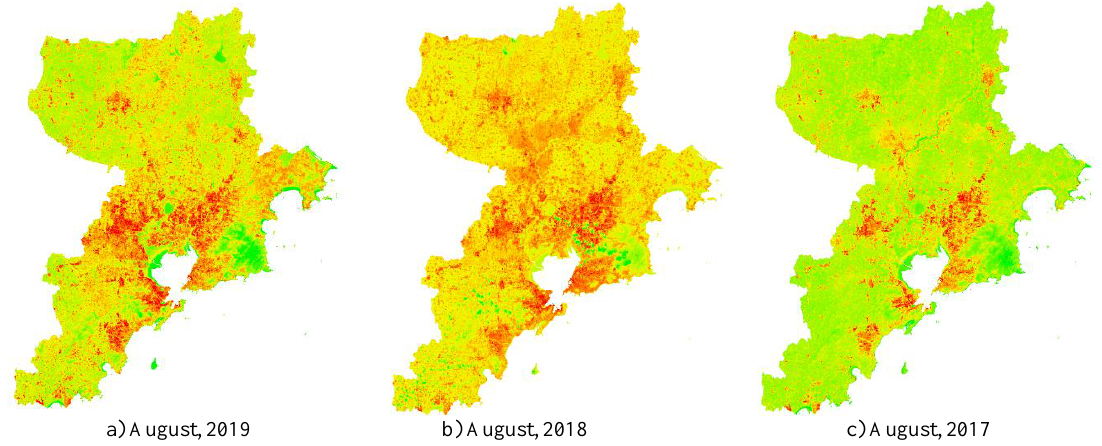
Figure 2. Inversion results of surface temperature in